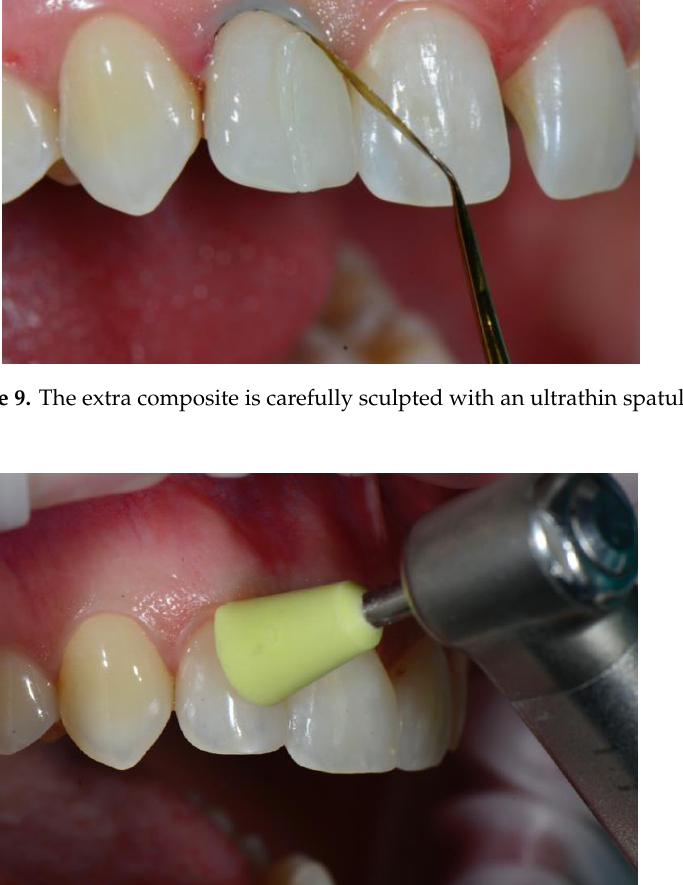
Figure 11. Finishing the interproximal spaces. Once all the veneers were bonded in position, the patient was dismissed and rescheduled for a post-operative evaluation two weeks later. At the recall appointment, a functional evaluation (absence of fractures, marginal adaptation), a biological evaluation (soft tissue response, post- operative sensitivity) and an esthetic evaluation (gloss, color matching) were completed and were fully satisfactory (Figures 12 and 13). As a final recommendation, oral hygiene instructions for the interproximal dental spaces were reviewed and the patient was rescheduled for a regular 6-month follow-up appointment. The highly translucent and glossy surface of the Veneer produced optimal esthetics with invisible transition between the veneer and the tooth. The lack of tooth preparation and the single- appointment procedure with no impressions, no temporaries and no try-ons minimized the stress for the soft tissues and greatly contributed to the reduced post-operative discomfort and excellent acceptance by the patient. Figure 12. Post-operative full-face view.